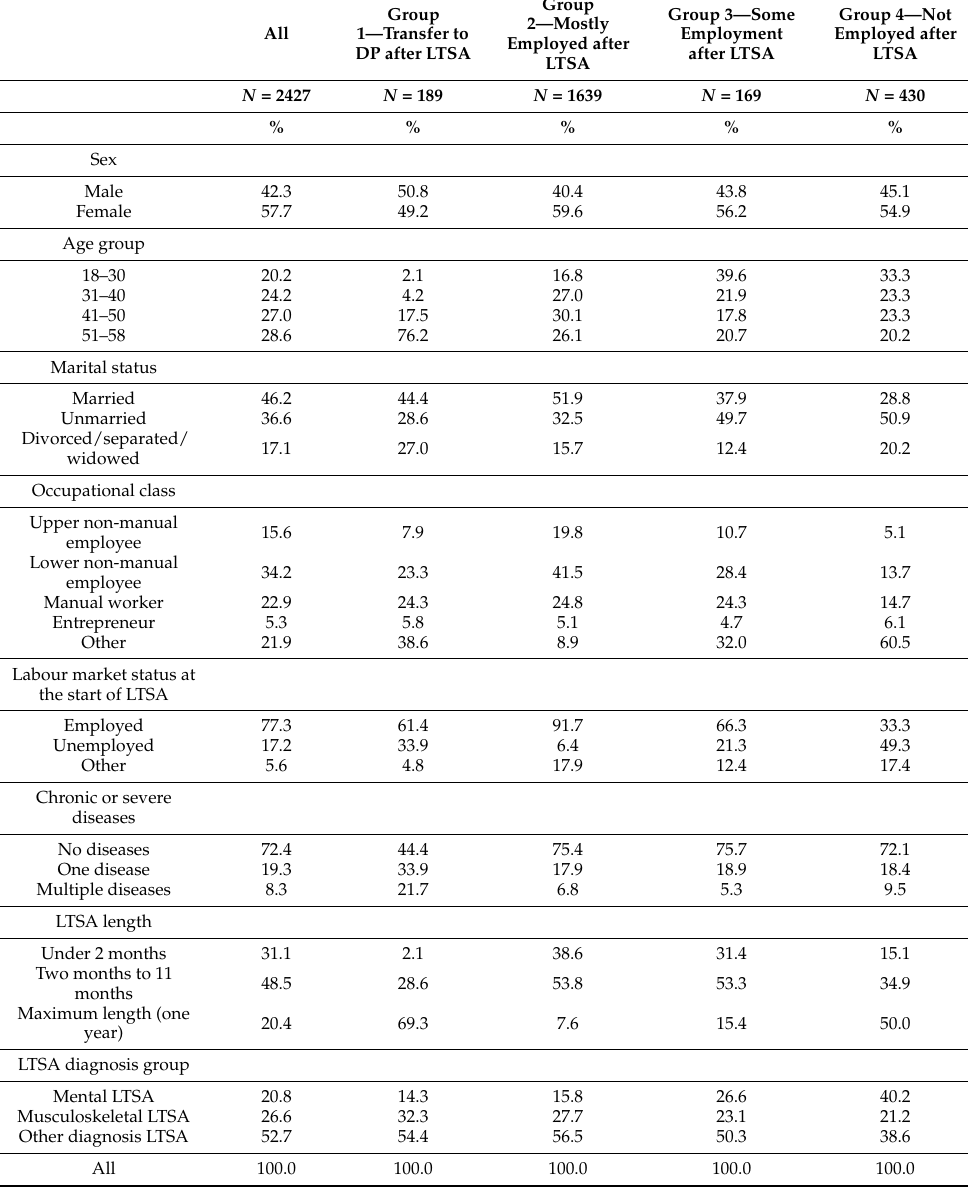
Table 1. The covariates in the study population and by LTSA